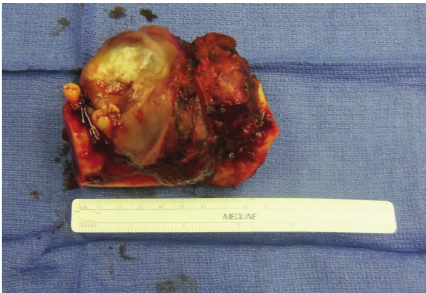
Figure 8: Final surgical